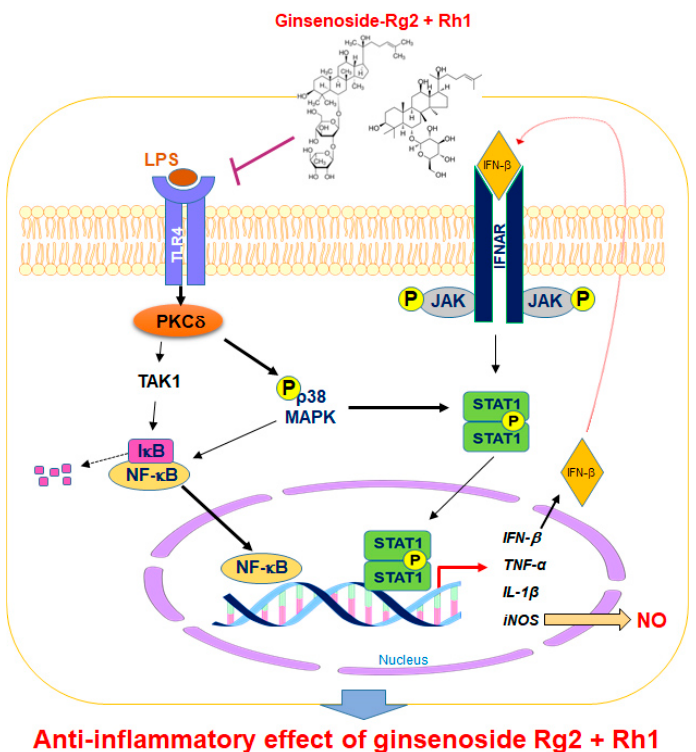
Figure 7. A schematic diagram showing the signaling pathways involved in anti-inflammatory effects of the combination of ginsenosides Rg2 and Rh1 in macrophages. The combination of ginsenosides Rg2 and Rh1 suppressed inflammation by abolishing the binding of LPS to TLR4, thereby inhibiting the TLR4-mediated signaling pathway. The combined ginsenosides Rg2 and Rh1 synergistically blocked LPS-TLR4 signaling-mediated PKC δ translocation to the plasma membrane, resulting in the decrease in p38-STAT1 activation and NF- κ B translocation. Additionally, the activations of p38 and IFN- β are associated with the phosphorylation of STAT1, which facilitates the dimer formation of STAT1. This allows STAT1 enter the nucleus and induce iNOS production. The NF- κ B translocation to the nucleus caused the transcription of inflammatory cytokines and mediators such as IFN- β , TNF- α , IL-1 β , and iNOS, but ginsenosides Rg2 and Rh1 significantly inhibited these inflammatory markers. LPS, lipopolysaccharide; TLR4, toll-like receptor 4; TAK1, transforming growth factor β -activated kinase 1; PKC- β , protein kinase C delta; NF- κ B, nuclear factor-kappa B; I κ B, inhibitor of kappa B alpha; MAPK, mitogen-activated protein kinase; JAK, janus kinase; STAT1, signal transducer and activator of transcription 1; IFN- β , interferon-beta; iNOS, inducible nitric oxide synthase; IL-1 β , interleukin-1 beta TNF- α , tumor necrosis factor-alpha; NO, nitric oxide; P, phosphorylation.